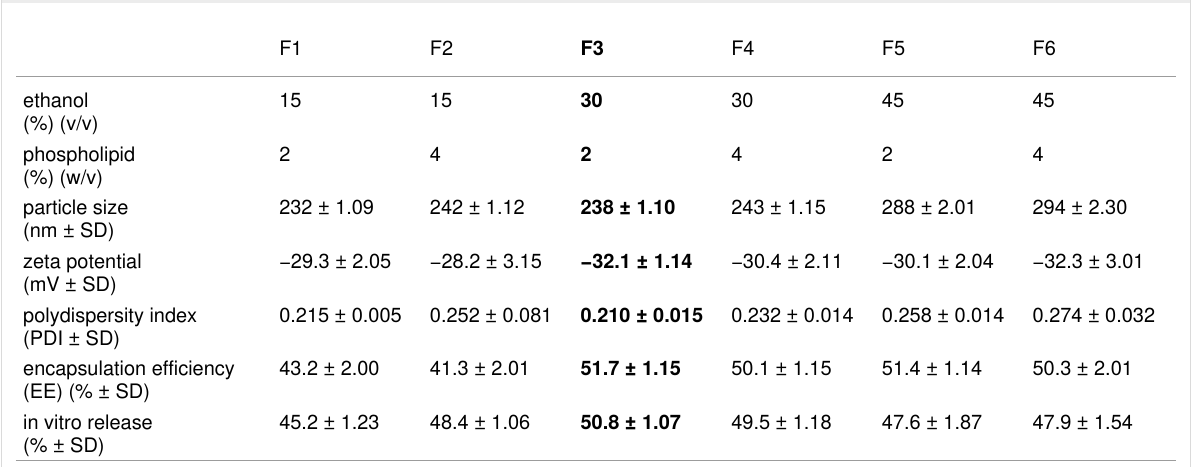
Table 1: Compositions and characterization parameters of six different EGCG-loaded ETHs a .